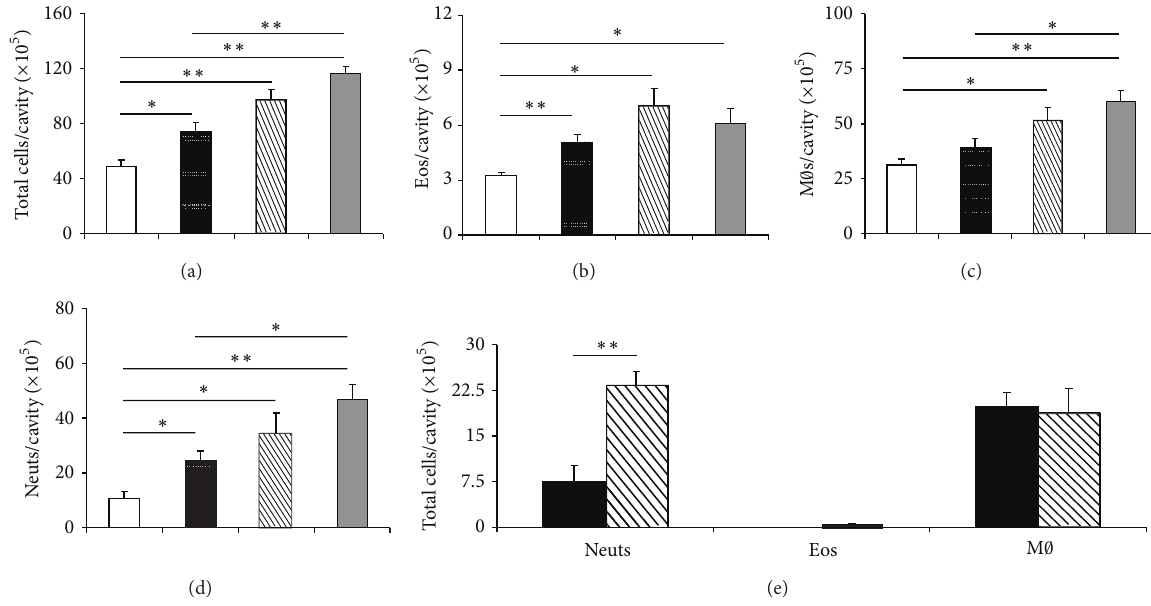
Figure 7: Effect of transfer of PAS or ALOX eosinophils on neutrophil accumulation in the peritoneal cavity of ALOX, PAS, and GATA-1 recipients. (a)–(d) ALOX mice received RPMI (open bars), PAS eosinophils (stippled bars), PAS eosinophils followed by eotaxin, 50ng/cavity, 30 minutes later (hatched bars). As positive controls, PAS mice received PAS eosinophils followed by eotaxin (gray bars). Peritoneal lavage fluid collected 4h after eotaxin injection was used for quantitation of total leukocytes (a), eosinophils (b), macrophages (c), and neutrophils (d). (e) GATA-1 mice received eotaxin (black bars), or ALOX eosinophils, followed by eotaxin, 30 minutes later (hatched bars). Peritoneal lavage fluid collected 4 h after eotaxin administration was used for quantitation of neutrophils (Neuts), eosinophils (Eos), and macrophages (M 𝜙 ). Data are mean ± SEM. ∗ , 𝑃 ≤ 0, 05 ; ∗∗ , 𝑃 ≤ 0, 01 , for the indicated differences. Data from 3–5